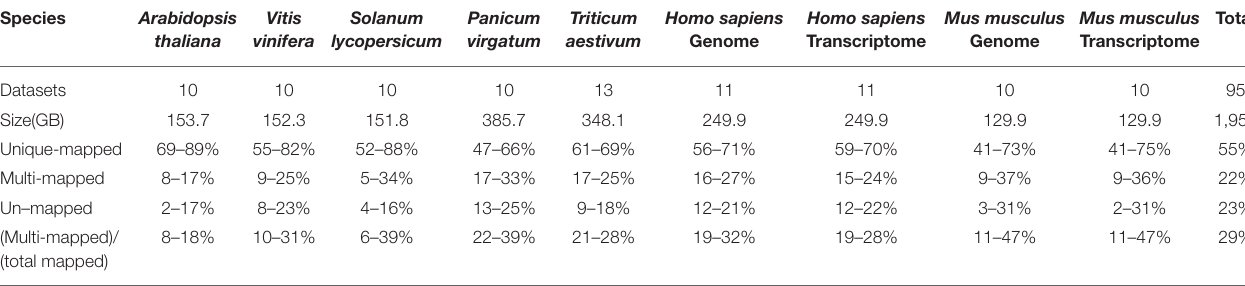
TABLE 1 | Multi-mapped